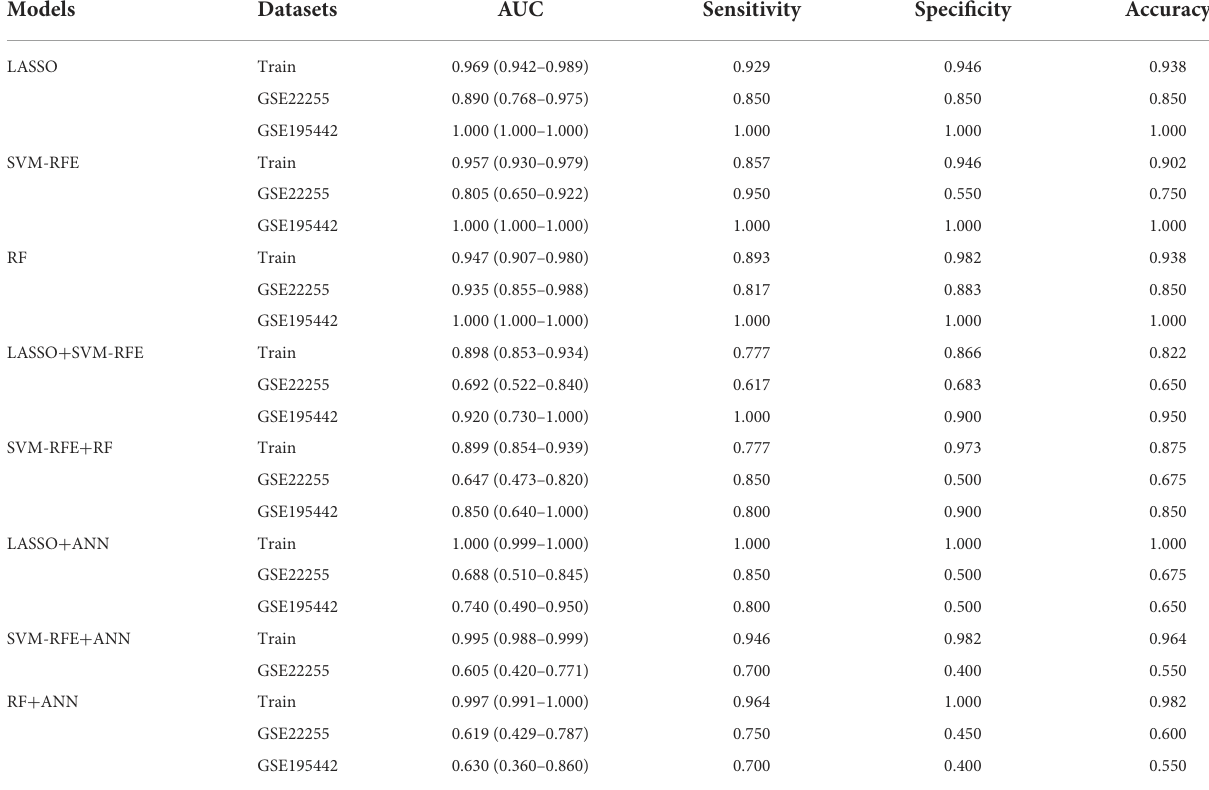
TABLE 3 Comparison of ischemic stroke diagnosis models based on machine